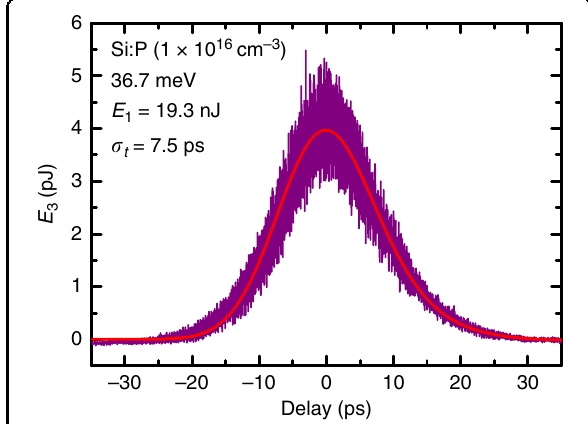
Fig. 4 An example transient output pulse energy ( E 3 ) as a function of delay between the input pulses (the k 1 and k 2 beams) for one of the Si:P samples far from resonance. The signal is a third-order autocorrelation of the pulse temporal pro fi le. This autocorrelation signal appears Gaussian to a good approximation (red line) with r.m.s. width σ t = 7.5 ps, so the inferred r.m.s. duration of the ffiffiffiffiffiffiffi p σ ¼ 6.1 2 = 3 pump beams is t 0 ¼ t